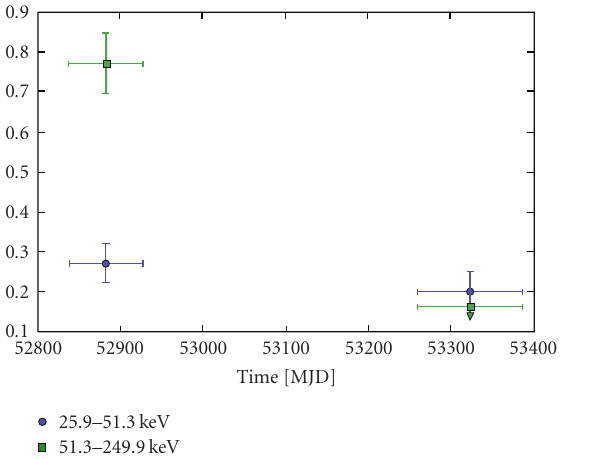
Figure 10: IBIS gamma-ray light curve of blazar 3C66A.